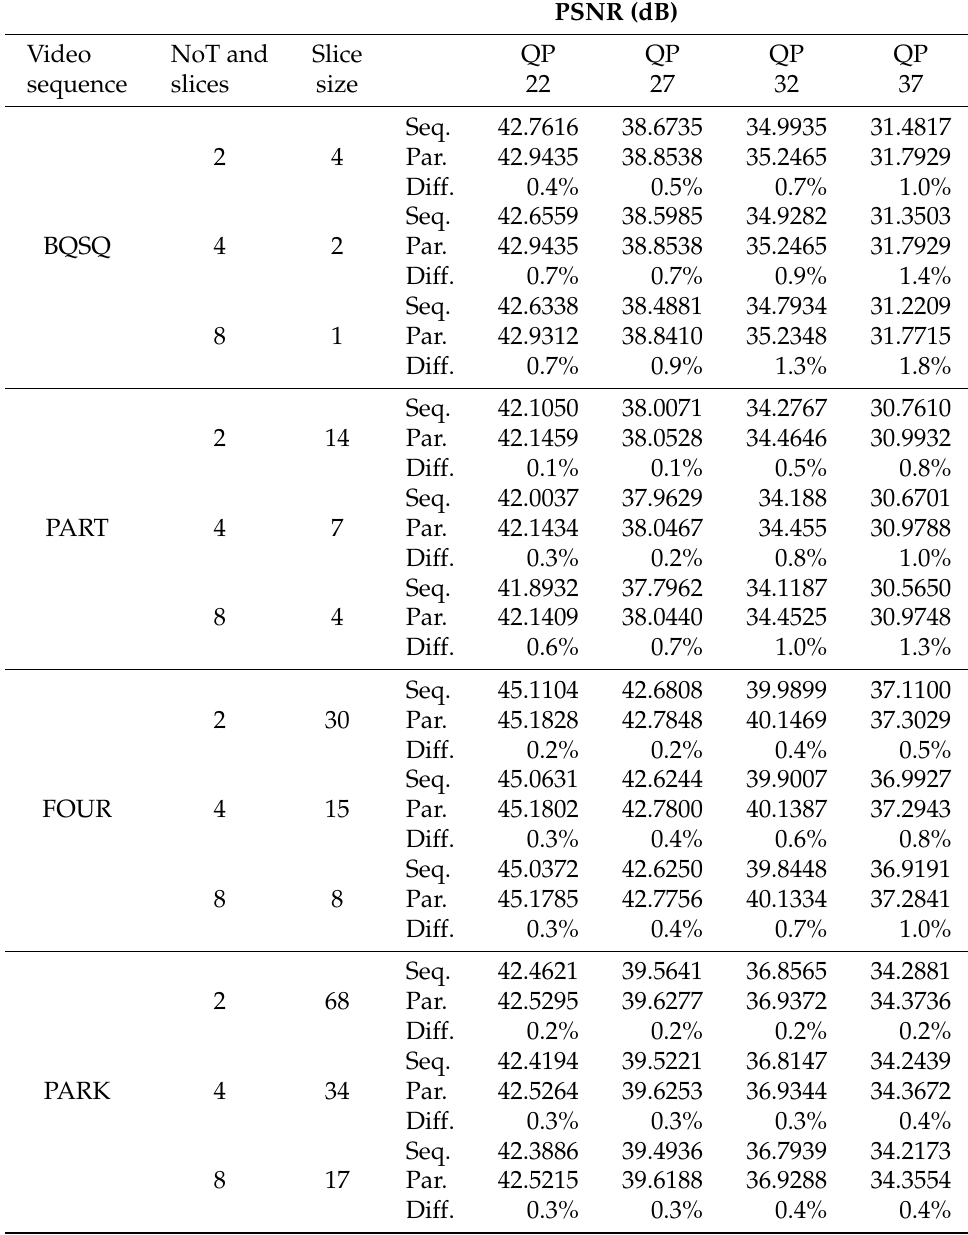
Table 17. Comparison of